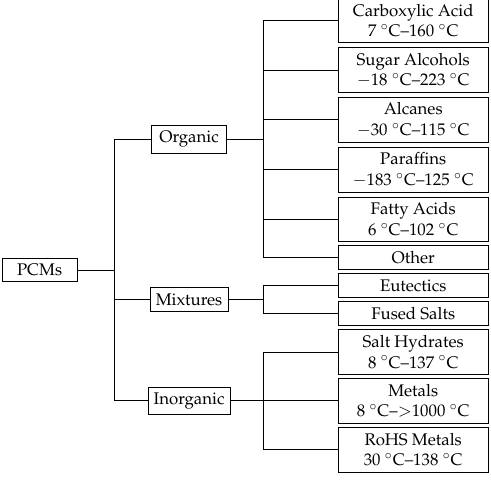
Figure 1. Overview of solid-liquid PCMs with their typical melting points at 1bar